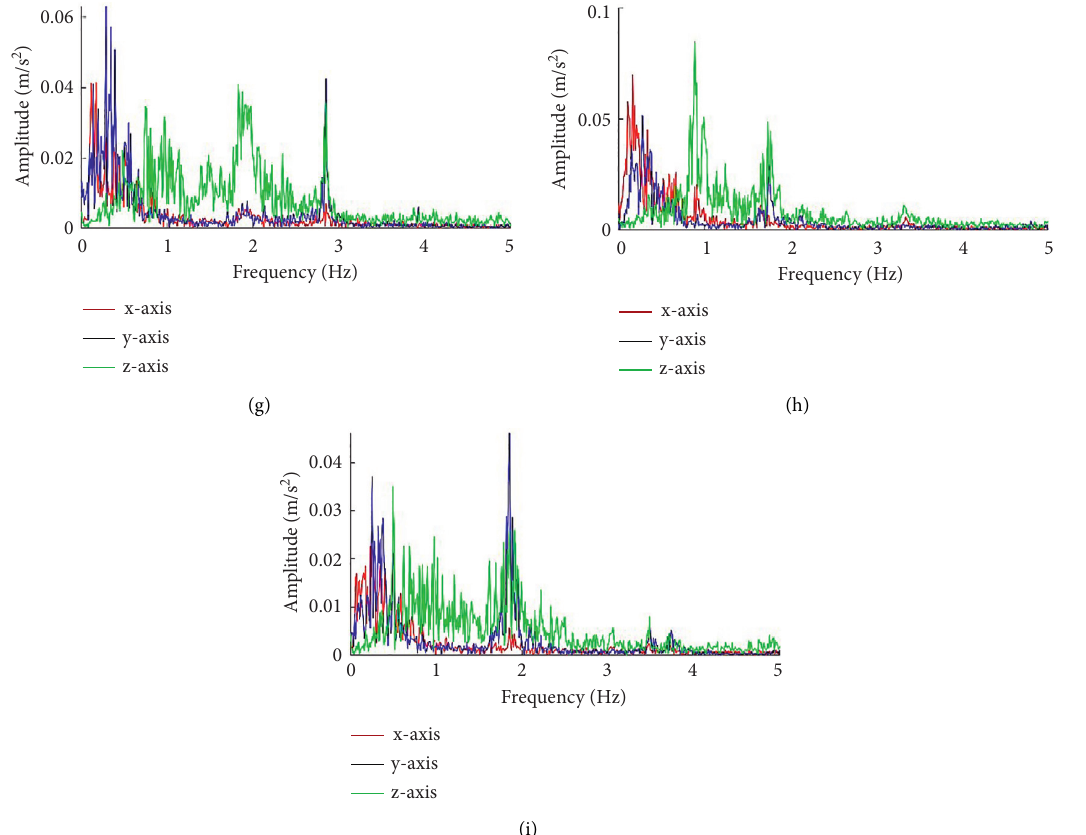
Figure 5: Fast Fourier transform response of the acceleration measured at seat pan during the experiments